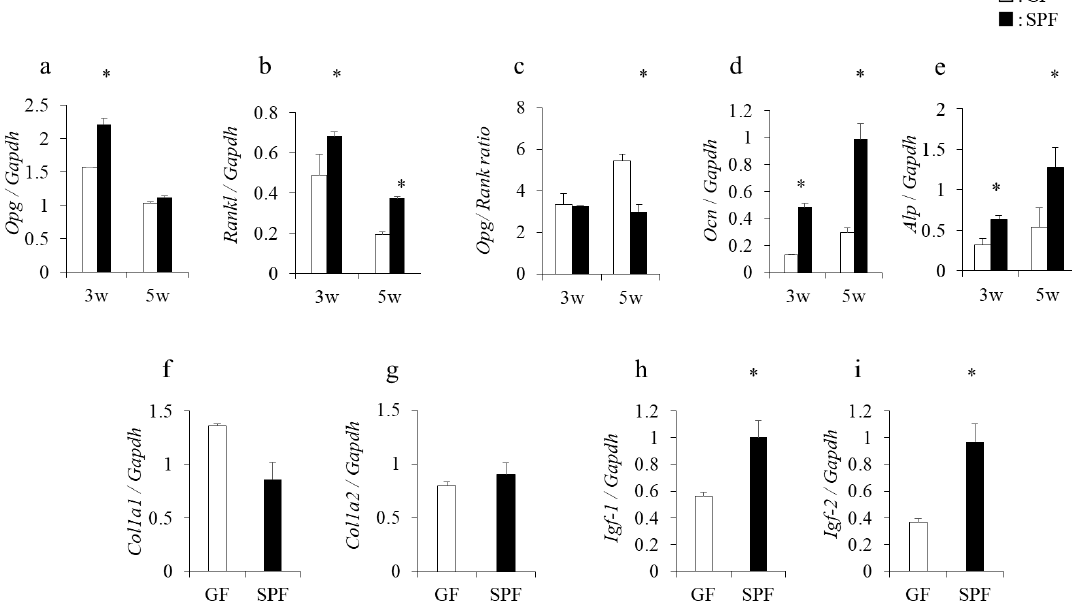
Figure 5. Osteogenic gene expression in calvarial primary osteoblasts. Calvariae from 8-week-old GF and SPF mice were harvested, and primary osteoblasts were isolated and cultured in osteoblast differentiation medium. After culture for the indicated times, total RNA was isolated, and real-time PCR analysis was performed to assess osteogenic gene expression. Significant differences in expression of the osteoprotegerin ( Opg ) gene ( a ), receptor activator of nuclear factor-kappa B ligand ( Rankl ) ( b ) gene, the Opg/Rankl ratio ( c ), osteocalcin ( Ocn ) ( d ) gene, and alkaline phosphatase ( Alp ) ( e ) gene were observed between GF and SPF osteoblasts. At 5 weeks of culture, no significant differences were observed in expression of the collagen type I alpha ( Col1a ) 1 ( f ) and Col1a2 ( g ) genes between GF and SPF osteoblasts. Expression of the insulin-like growth factor ( Igf-1 ( h ) and Igf-2 ( i ) genes was significantly higher in SPF osteoblasts than GF osteoblasts at 5 weeks. * p < 0.05, t -test ( n = 4/group).